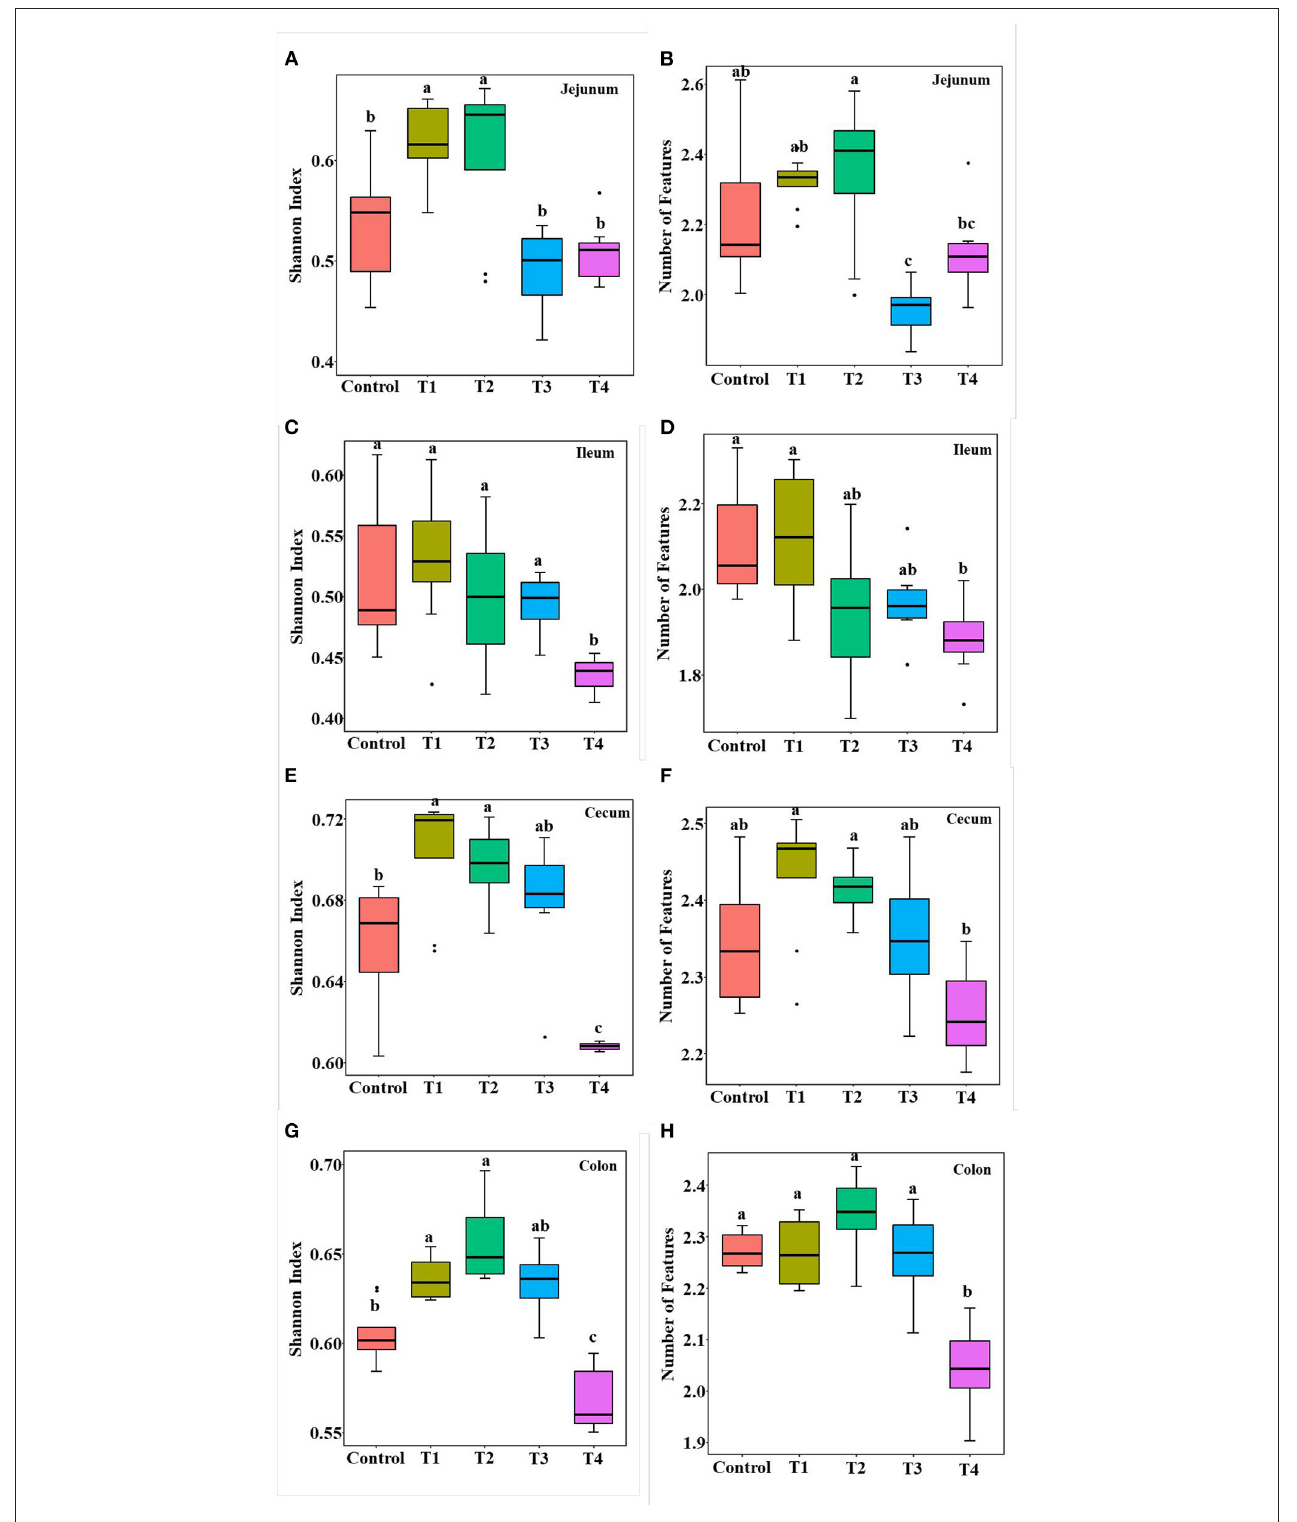
FIGURE 2 | Alpha diversity including Shannon index (A,C,E,G) and the number of features (B,D,F,H) in control group, Trichlorogalactosucrose (TGS) 1–4 (T1, T2, T3, T4) groups in jejunum (A,B) , ileum (C,D) , cecum (E,F) , colon (G,H) . Data was processed through log10, and expressed as mean ± SEM ( n = 8) and analyzed by one-way ANOVA analysis. The different superscript letters on the boxplot represent a significant difference ( P < 0.01).